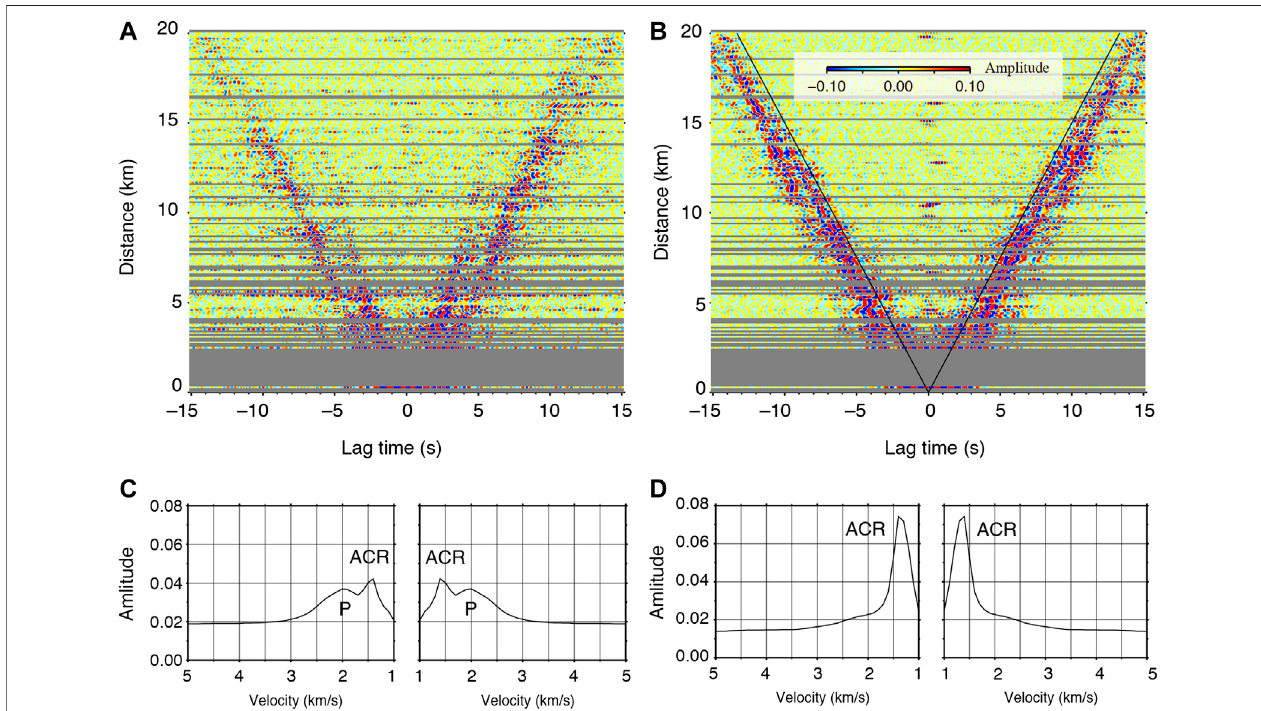
FIGURE 4 | CCFs aligned as a function of the separation distance oftwo stations. (A) Z-Z CCFs at 1 – 3 Hz using short-period sensor. (B) Same as (A) , but for P-P CCFs using hydrophone. Solidlineindicates awavepropagation with avelocity of1.5 km/s. (C) Slant stack results for (left) negative and (right) positivelag times ofthe CCFs in (A) . (D) Same as (C) , but for the CCFs in (B) .